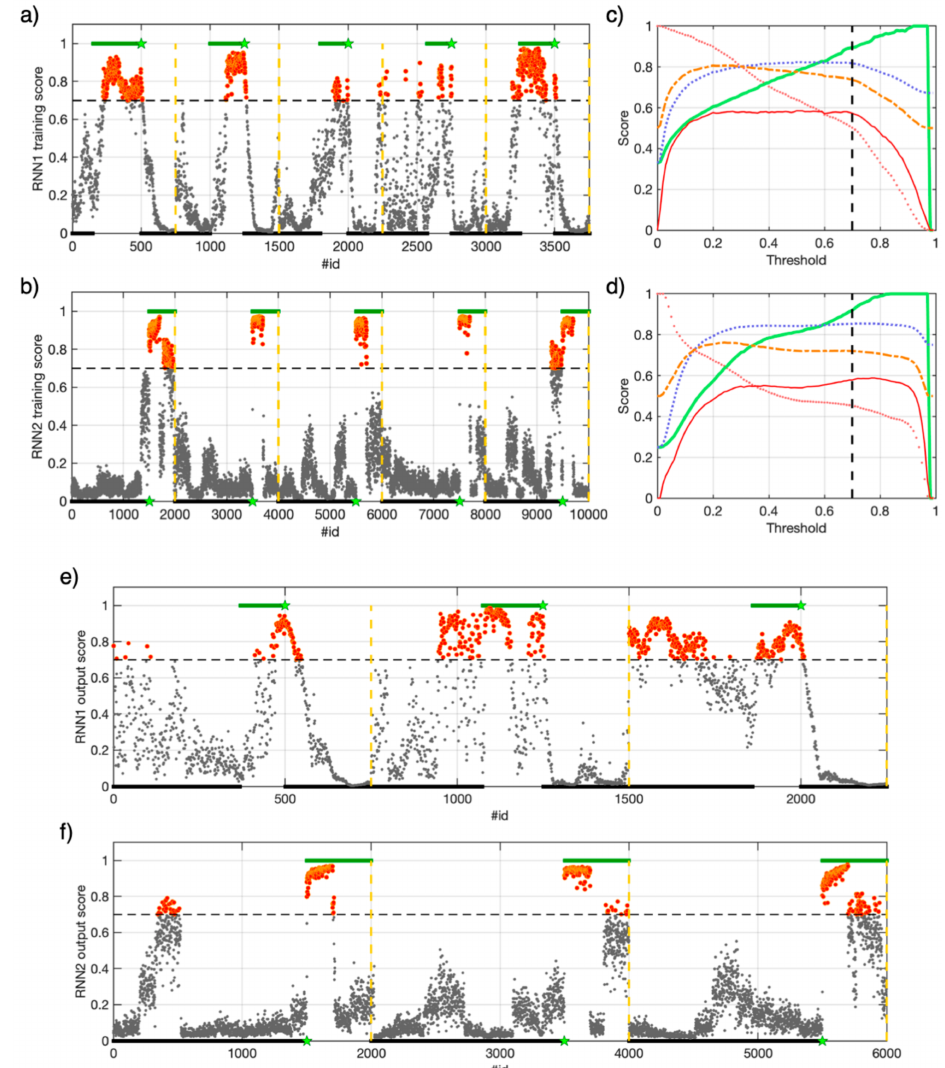
Figure 6. ( a ) RNN1 training. Labels for background and aftershocks (black), while for preparatory events (green), M4 events (green stars), end of the M4 series (vertical, dashed yellow line), selected threshold (horizontal, dashed black line), RNN1 output below the threshold (grey), and above it (orange). ( b ) The same as ( a ), but for RNN2 and with label for background and foreshocks (black), while for aftershocks (green). ( c ) Performance criteria versus threshold: recall (red dotted line), precision (green thick line), accuracy (blue square dotted line), balanced accuracy (dashed orange line), and MCC (red thin line) for RNN1. Selected threshold (vertical, dashed black line). ( d ) The same as ( c ), but for RNN2. ( e ) The same ( a ) but for the testing dataset and RNN1 (three M4 testing series). ( f ) The same as ( b ) but for the testing dataset and